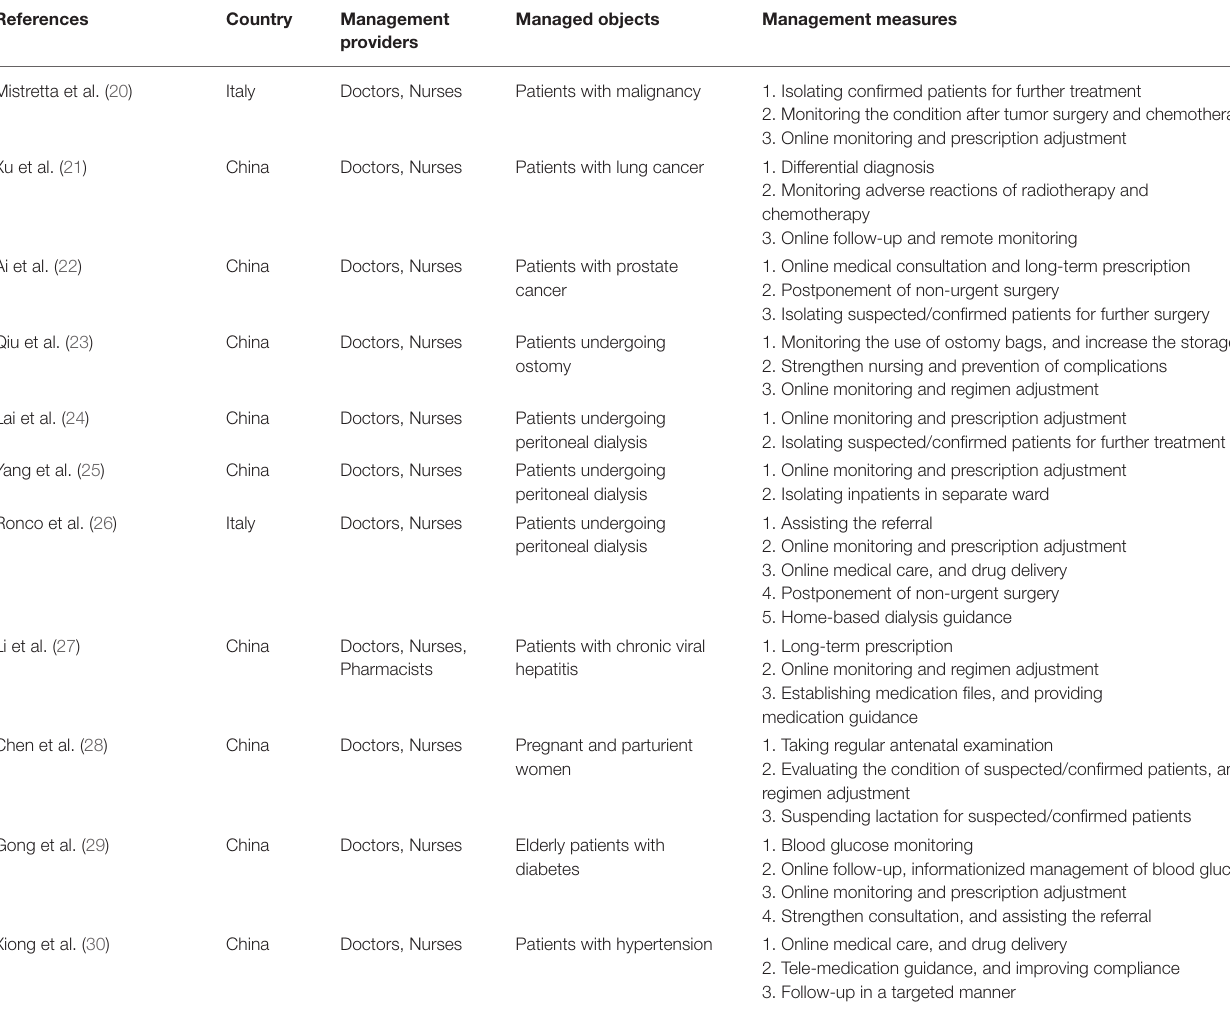
TABLE 1 | Evidence table of studies about patient management of clinical specialties during the COVID-19